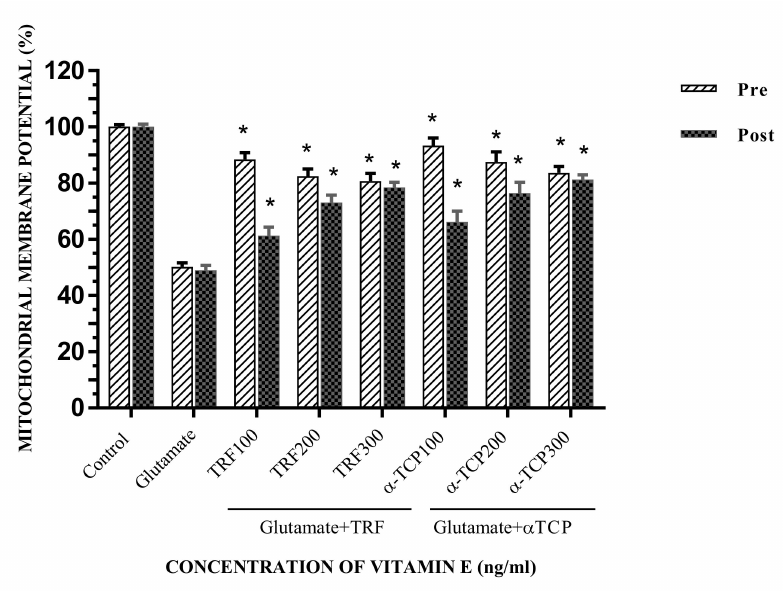
Figure 4. The effect of pre- and post-treatment with TRF and α -TCP on glutamate-injured astrocytes with respect to mitochondrial membrane potentiality. Data represent the mean ± SEM of three independent experiments ( n = 3 in each experiment). * p < 0.05, TRF- and α -TCP-treated groups compared with the glutamate-treated group. This shows that TRF and α -TCP, at a low concentration (100 ng) in pre-incubation, and at a high concentration (300 ng) in post-incubation, demonstrated better prophylactic properties against the toxicity of glutamate in primary